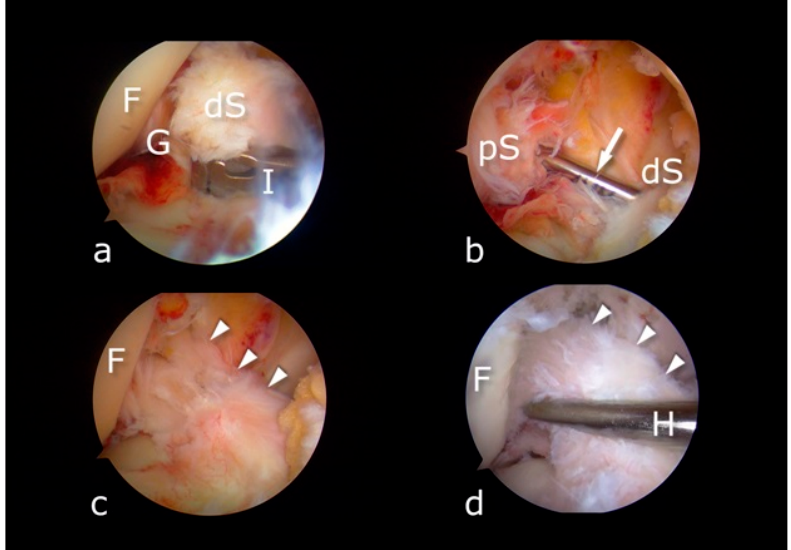
Figure 8. ( a ) Primary ACL repair. Distal stump (dS) waving in front of the intercondylar notch of the femur (F) with a gap (G) opening after retraction by suturing instrument (I). ( b ) Proximal stump (pS) drilled (arrow). Distal stump (dS) was retracted at this stage. ( c ) After completion of the procedure, the tension of the repaired ACL (arrowheads) and FiberTape was confirmed. ( d ) Second look surgery due to poor range of motion. After scaring tissue removal physiological tension of the healed ACL was confirmed by hook (H) traction.